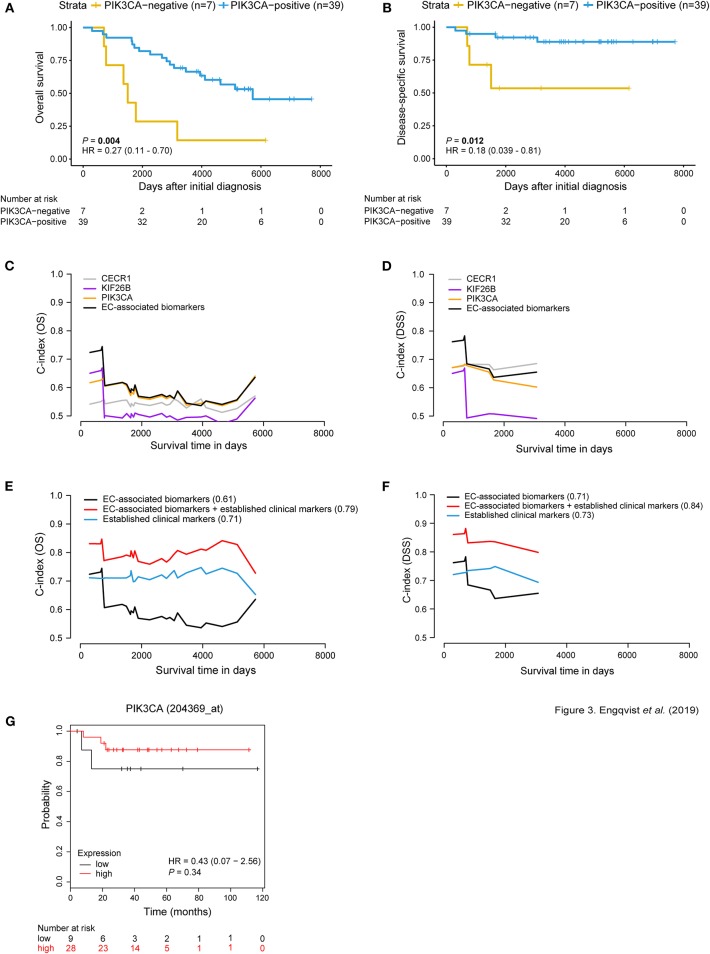
Prognostic significance of EC-related biomarkers. Survival analysis using Kaplan-Meier plots (A,B) depicting OS and DSS patient survival in relation to dichotomized PIK3CA protein expression. Positive PIK3CA protein expression (blue curve) was associated with longer OS and DSS [P-value = 0.004, HR = 0.27 (95% CI 0.11–0.70); P-value = 0.012, HR = 0.18 (95% CI 0.039–0.81)]. The x-axis depicts days after initial diagnosis and the y-axis survival outcome (OS/DSS). The patient numbers at risk by time (days after initial diagnosis) is shown below the Kaplan-Meier plot. Univariable and multivariable survival analysis for OS/DSS (C,D) showing AUC(t) plots of individual EC-associated biomarkers and in combination (black curve). Multivariable survival analysis (E,F) illustrating improved predictive performance for both OS and DSS when combining protein expression of the EC-related biomarkers with established clinical markers (C-index = 0.79; 0.84). C-index values for each curve are shown in parentheses. Survival analysis was adjusted for age, stage, CA125, ploidy. The x-axis depicts survival time in days and the y-axis C-index values (OS/DSS). KM plotter was used to test the prognostic value of the EC-associated biomarkers in an external ovarian carcinoma dataset containing EC patients (n = 37). Here, PIK3CA gene expression is not associated with OS (G). However, RNA and protein expression for PIK3CA displayed similar trends, where patient samples with low expression shorter OS. Cox proportional hazard model and log-rank tests were used to calculate HR, 95% confidence interval, and log rank P-value for Kaplan-Meier survival analysis and KM Plotter validation analysis.